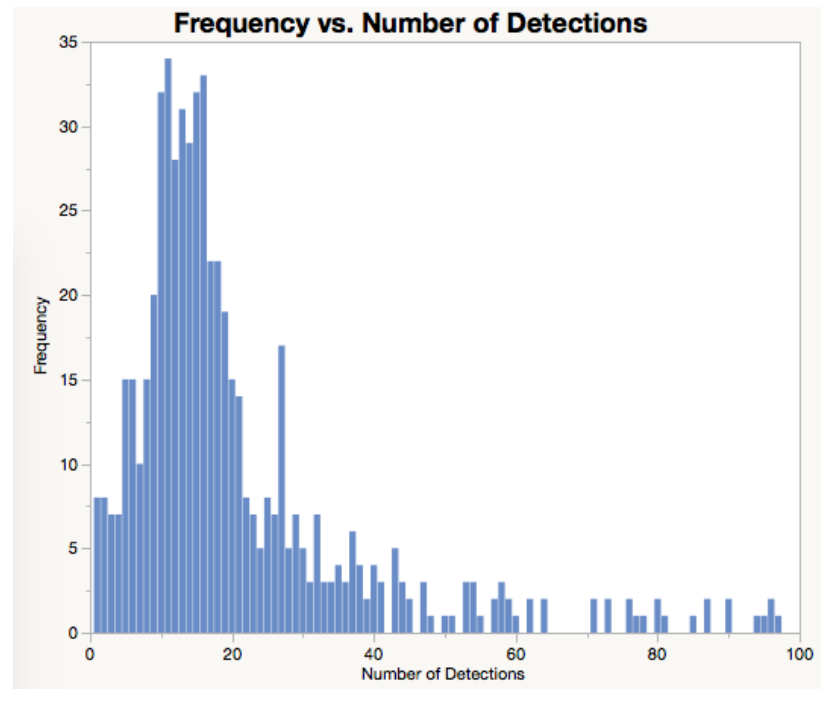
Figure 12. Number of detections registered per event. This data illustrates that bees are expected to be detected several times as they move near RFID